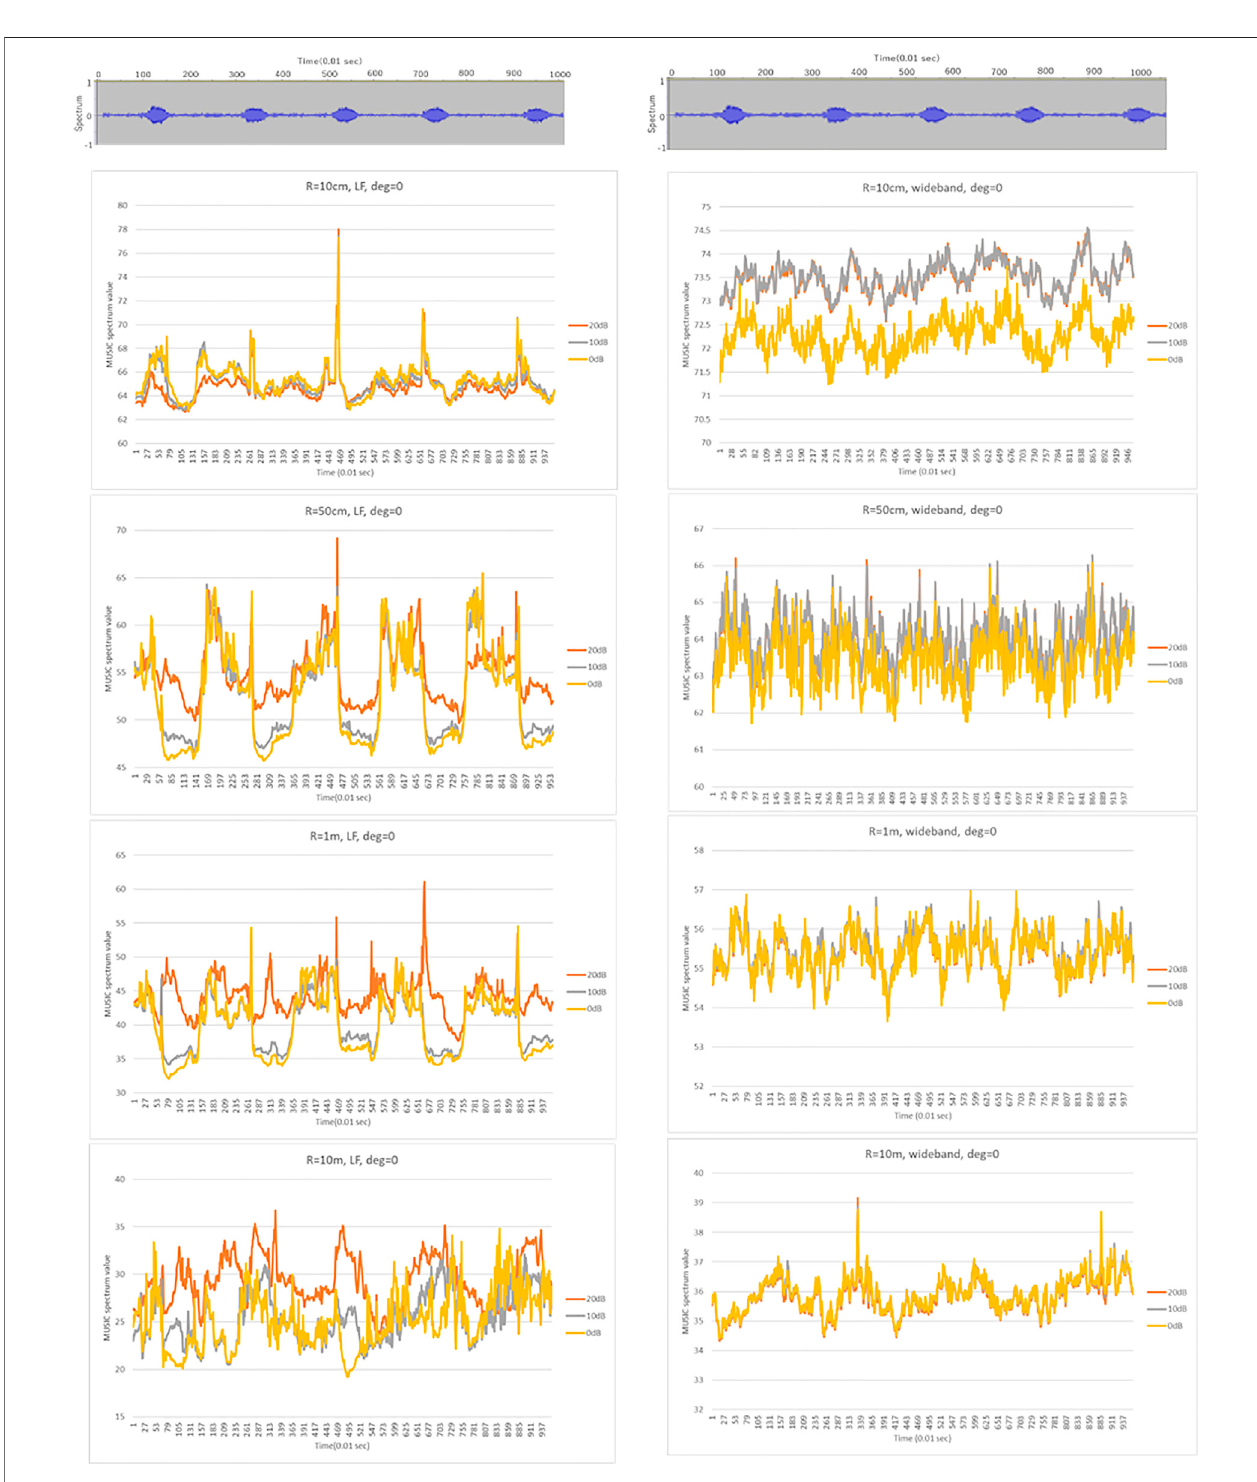
FIGURE 5 | MUSIC spectrum in time for LB (left) and WB (right). The top subgraphs show the input signals in time domain, and the remaining subgraphs illustrate the MUSIC spectrum for the target direction (0 ° ) over all frames for the corresponding frequency range. The horizontal and vertical axes are the simulation frame and MUSIC spatial spectrum values. The peaks in each subgraph show the presence of the sound source.